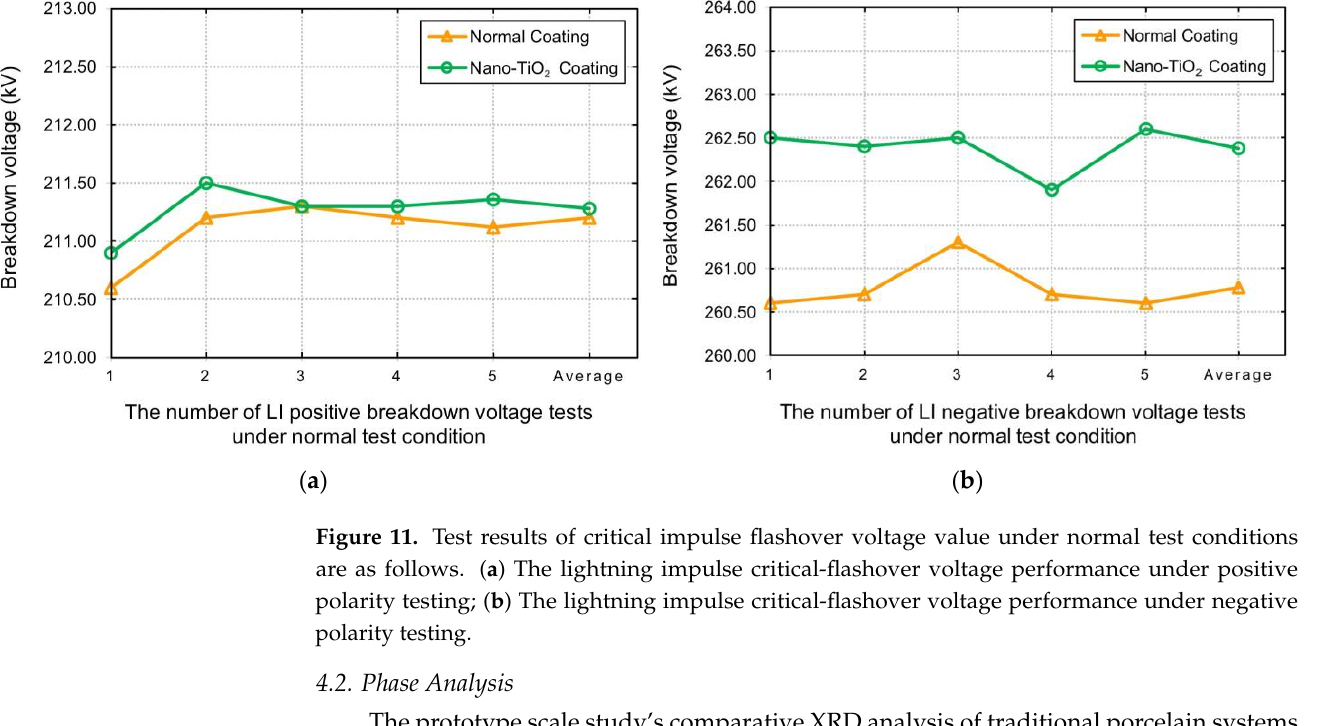
Figure 12. Test results of critical impulse flashover voltage value under contaminated test conditions are as follows. ( a ) The lightning impulse critical-flashover voltage performance under positive po- larity testing; ( b ) The lightning impulse critical-flashover voltage performance under negative po- larity testing. 4.2. Phase Analysis The prototype scale study ’ s comparative XRD analysis of traditional porcelain sys- tems and nanostructured porcelain systems in the sintered condition. Figure 13 shows the XRD patterns of prototype porcelain insulators with conventional coatings and nano-TiO 2 coatings measured by the Bruker D2 phaser at 30 kV, 10 mA. The results of this study revealed that the primary crystalline phases in the porcelain insulator prototype compo- sition were quartz (SiO 2 ) and mullite (3Al 2 O 3 •2SiO 2 ). The primary crystalline phases of the nanostructured porcelain ’ s diffraction pattern remained the same, and corundum, an unaltered form of alumina, was also present. Figure 13a shows alumina peaks in formu- lations with a high proportion of traditional porcelain insulators. Furthermore, as illus- trated in Figure 13b, adding a TiO 2 layer to the surface of outdoor insulators improves